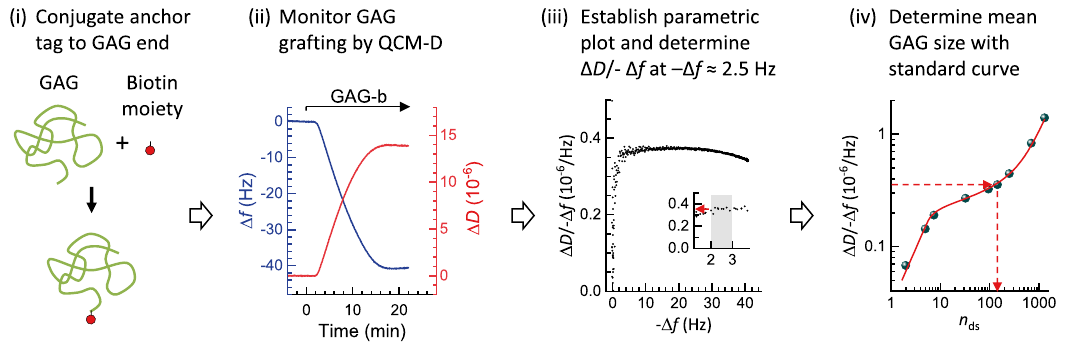
Figure 7. Flow diagram of the process of sizing surface-grafted GAGs. The four main steps are